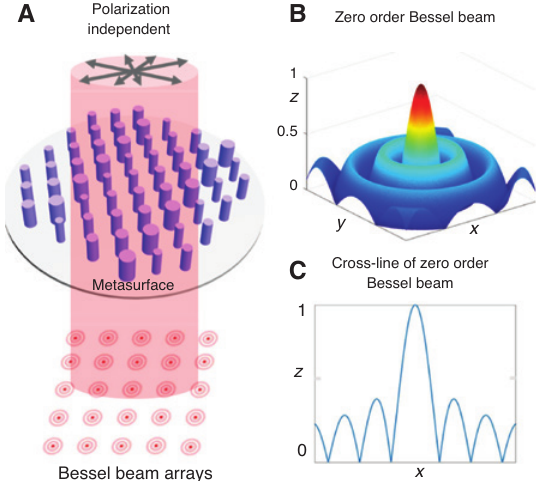
Figure 1: Schematic of the Bessel beam array generation based on HMS. The gray arrows indicate the polarization of the incident light: (A) illustration of HMS composed of nanoposts to generate Bessel beam arrays; (B) 3D image of a Bessel beam; and (C) the cross-section line of a single Bessel